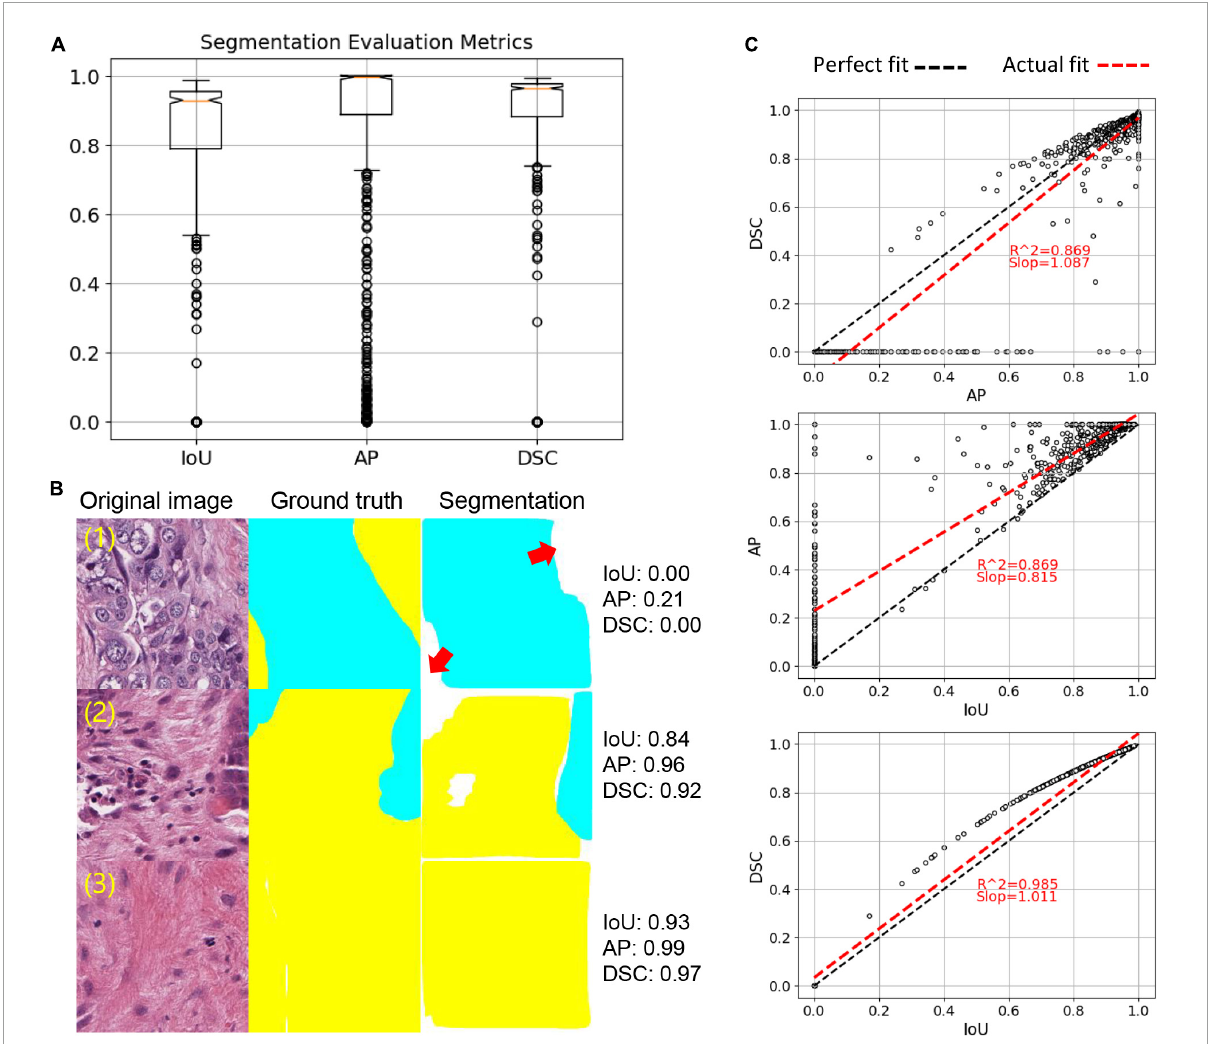
FIGURE3 Tumor-stroma segmentation evaluation. (A) Boxplot of three evaluation metrics, including IoU, AP and DSC. (B) Examples of segmentation. Red arrows point to missed targets in segmentation. (C) Correlation of three evaluation metrics. Each dot represents an image sample. Linear regression was used to calculate